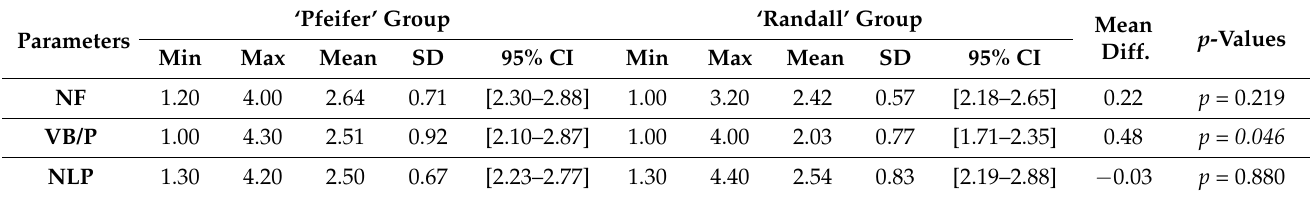
Table 2. Displaying the statistical results determined according to respective parameters NF (nasal frontal); VB/P (vermilion border and philtrum length) and NLP (nasolabial profile); (SD—standard deviation; CI—confidence interval; mean diff.—mean